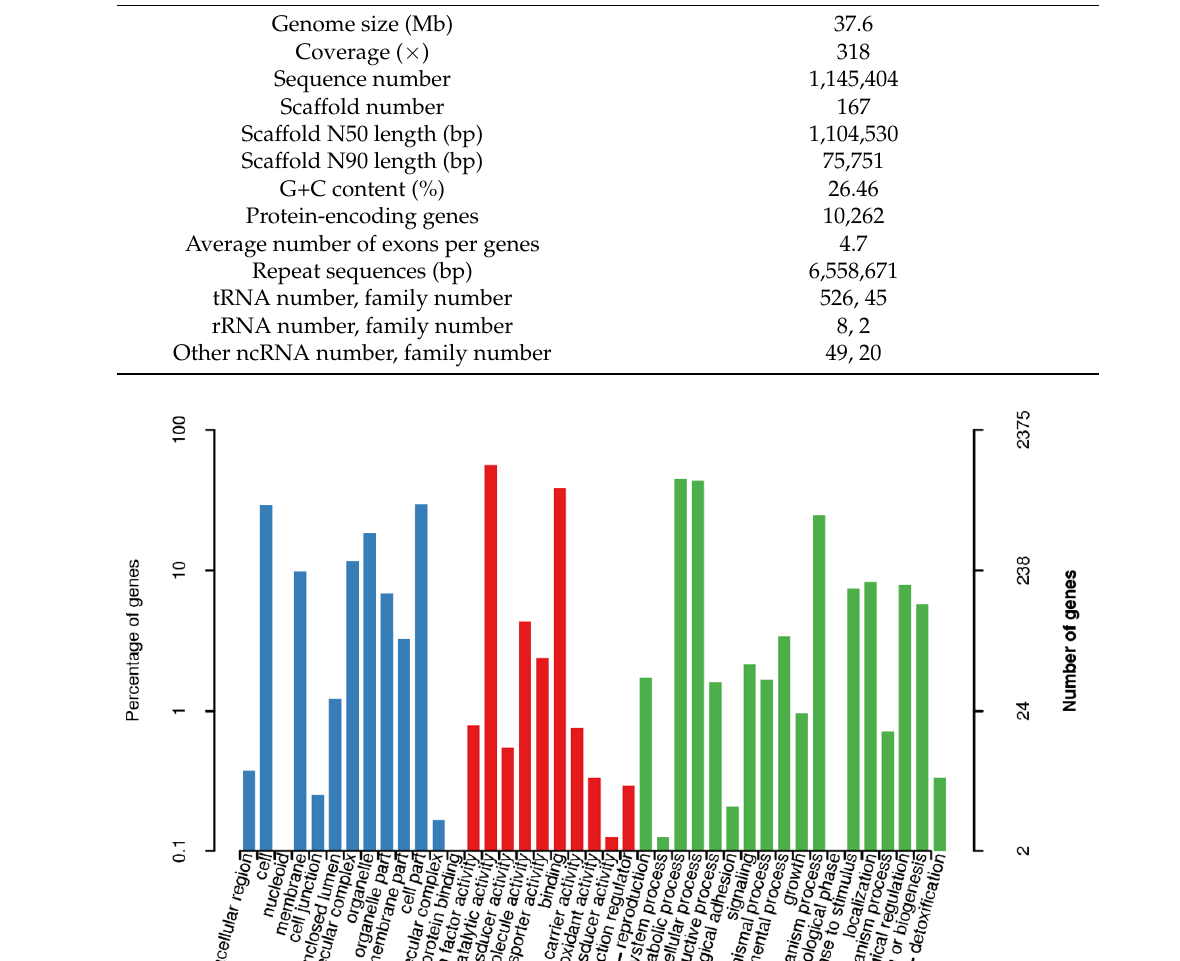
Figure 2. The KEGG functional annotation of C. obscurus genome. The major classes (distinct color) with their names and the number of genes from the concerned sub-class divisions are represented.